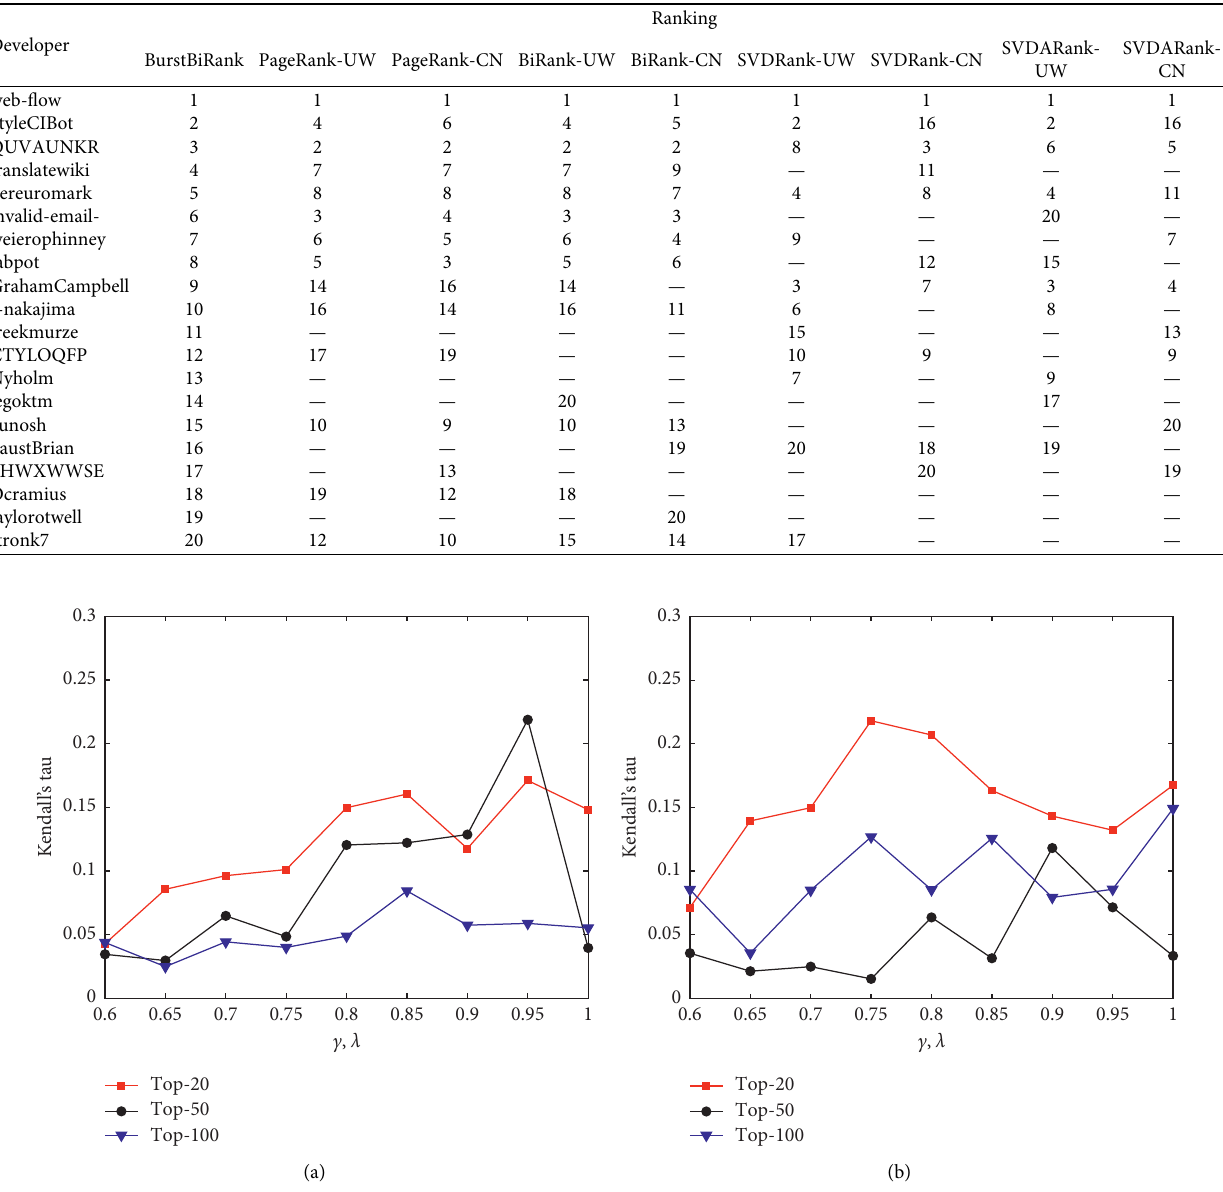
Figure 8: Parameter analysis for (a) developers’ ranking performance and (b) projects’ ranking performance.